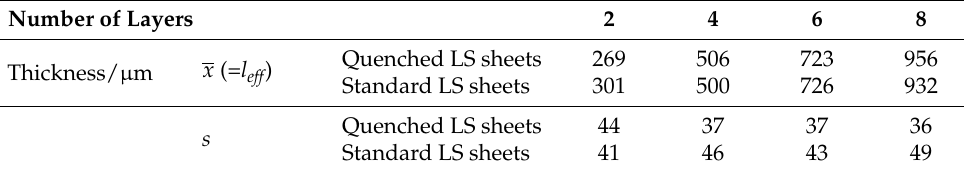
Table 3. Average value ( x = l eff ) and standard deviation ( s ) of the thickness distribution of quenched and standard laser-sintered (LS) polyamide 12 sheets generated with two, four, six, and eight layers. Number of Layers 2 4 Thickness/ µ